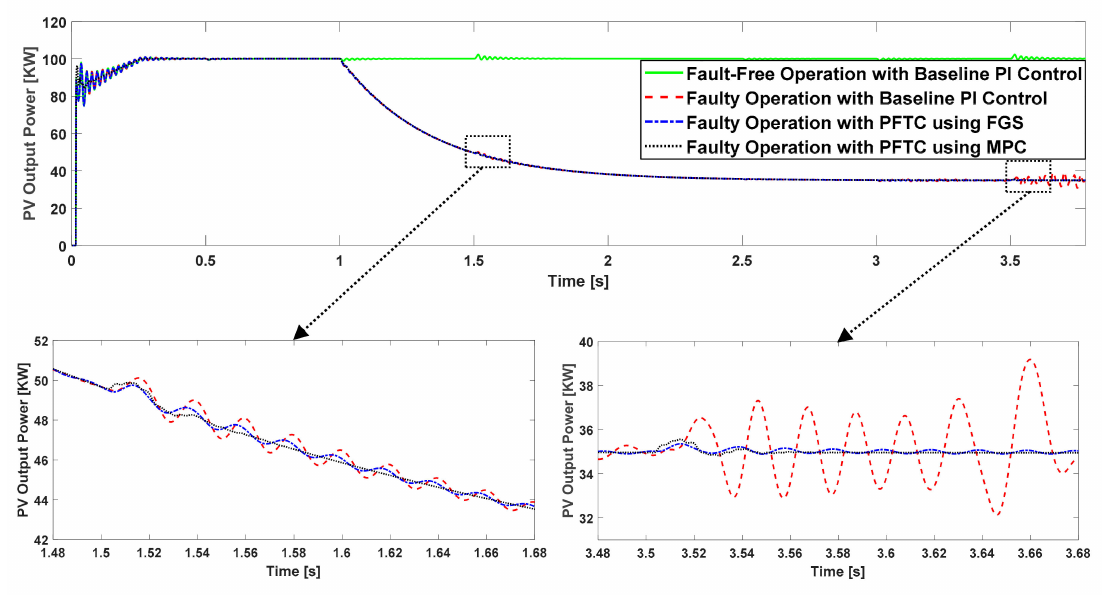
Figure 17. PV output power during fault-free and faulty operations (65% power-loss